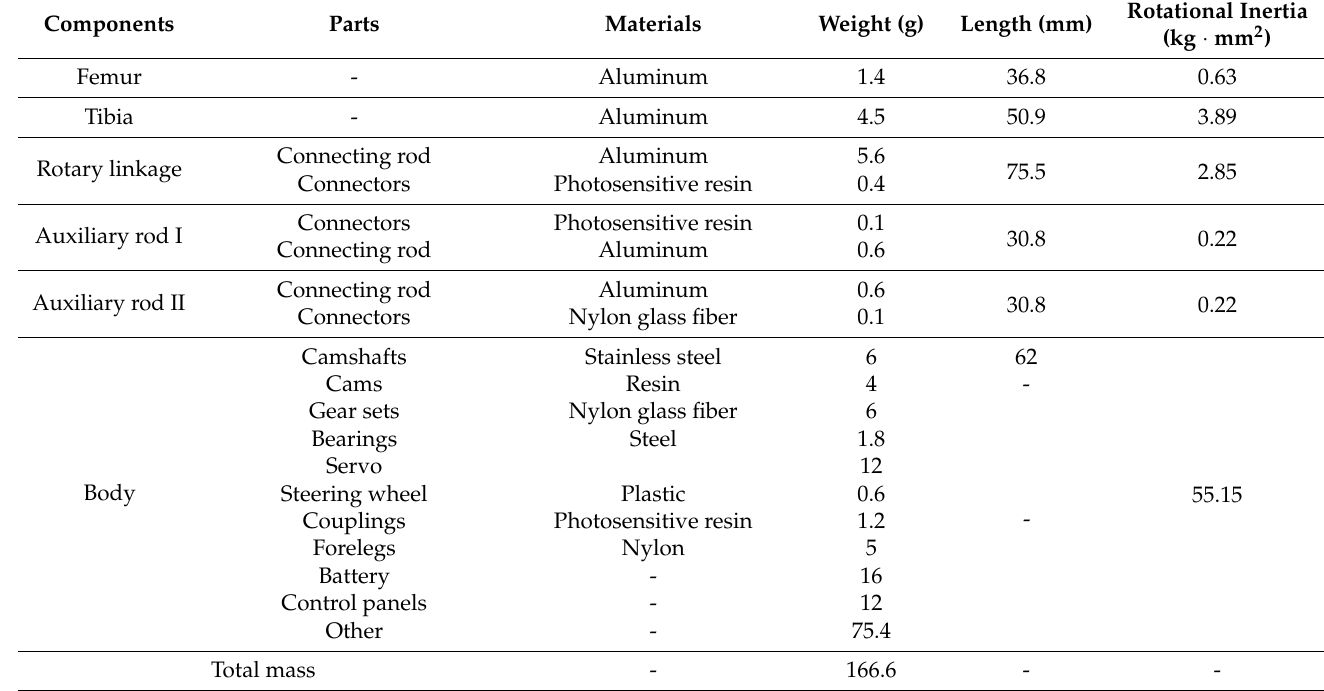
Table 1. Relevant parameters for robot